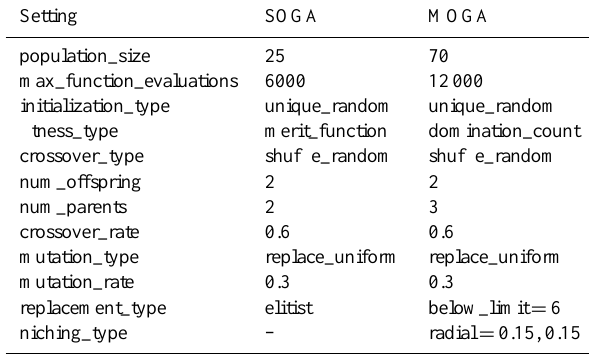
Table 1. Settings used in the genetic algorithms.